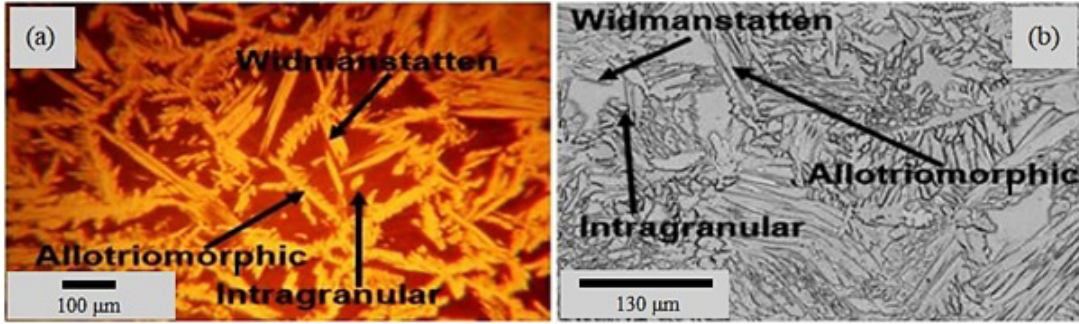
Figure 7. (a) HAZ microstructure showing three austenite morphologies from the top section view: alotriomorphic, Widmanstätten and intragranular obtained by OM (Magnification of 200x). (b) SEM of FZ exhibiting three austenite morphologies from the top section view: alotriomorphic, Widmanstätten and intragranular (Magnification of 1000x).